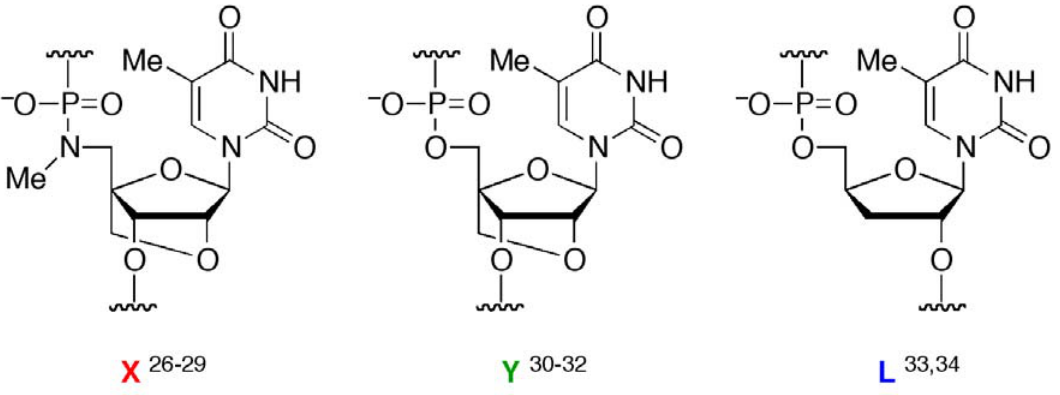
Figure 1. Structures of X (5’-amino-2’,4’-BNA), Y (2’,4’-BNA/LNA), and L (2’,5’-linked